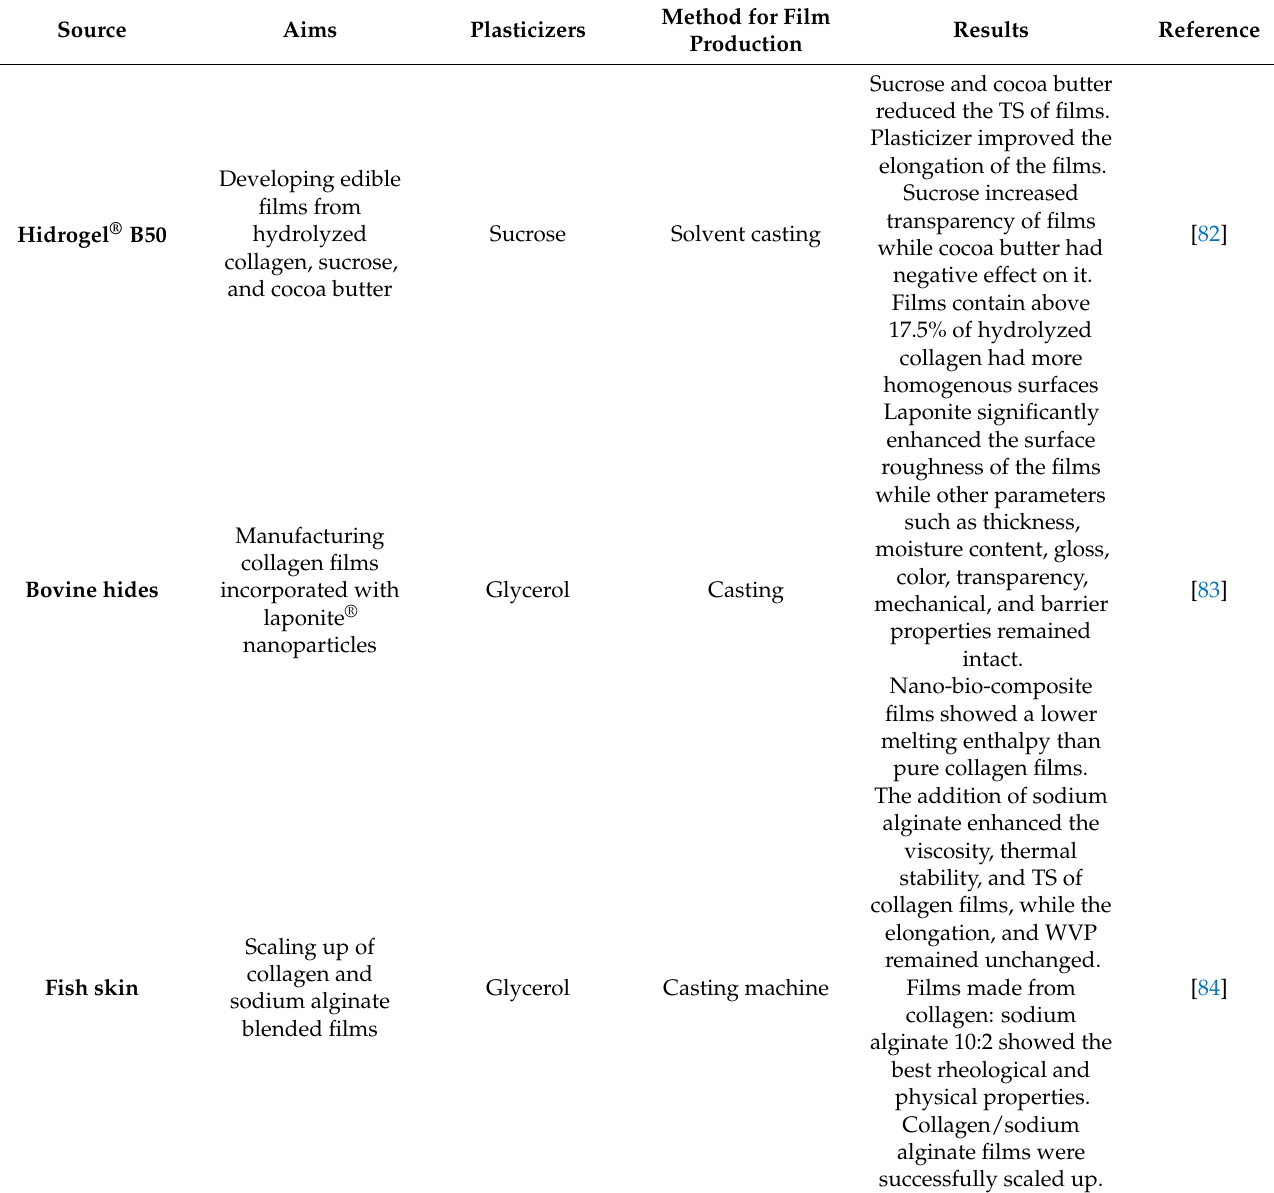
Table 2. Collagen films developed from different animal by-product